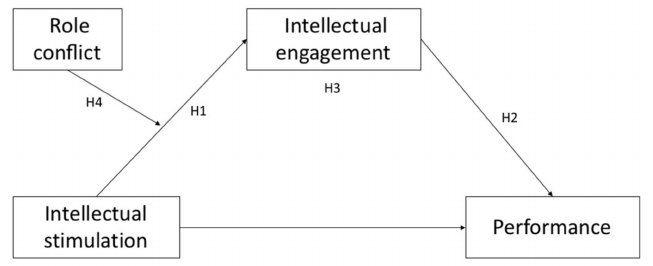
Figure 1. Research model; Own